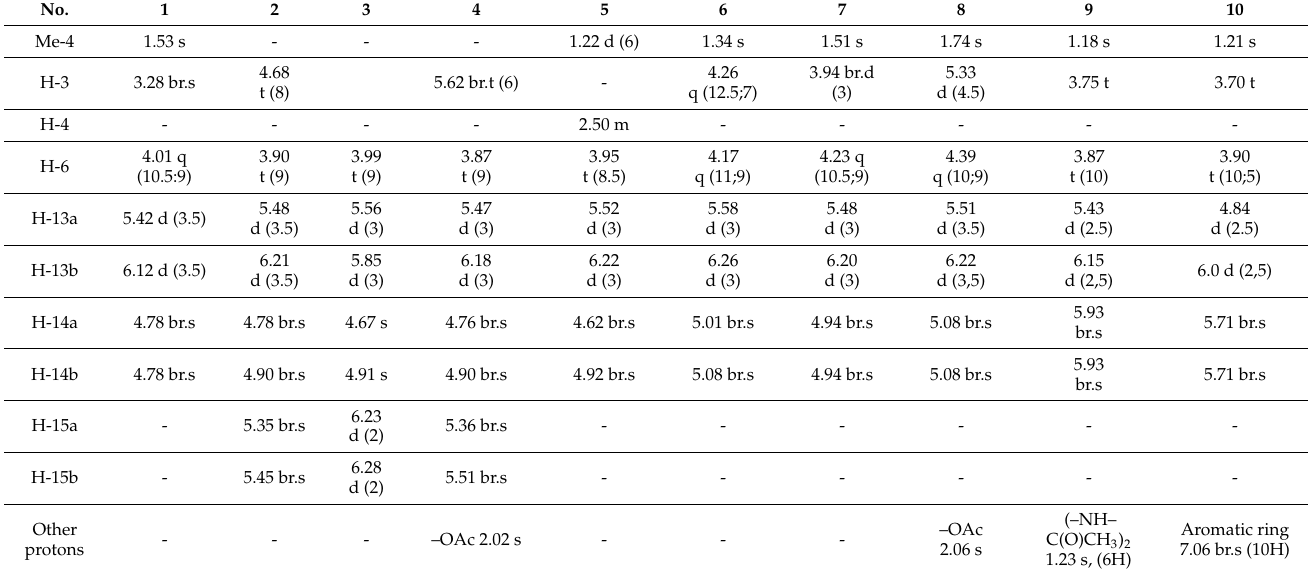
Table 1. Chemical shifts (in ppm) and spin–spin coupling constants ( 1 H NMR, 500.16 MHz, CDCl 3 , δ , ppm, in brackets, in Hz) for estafiatin 1 and its derivatives 2 – 10